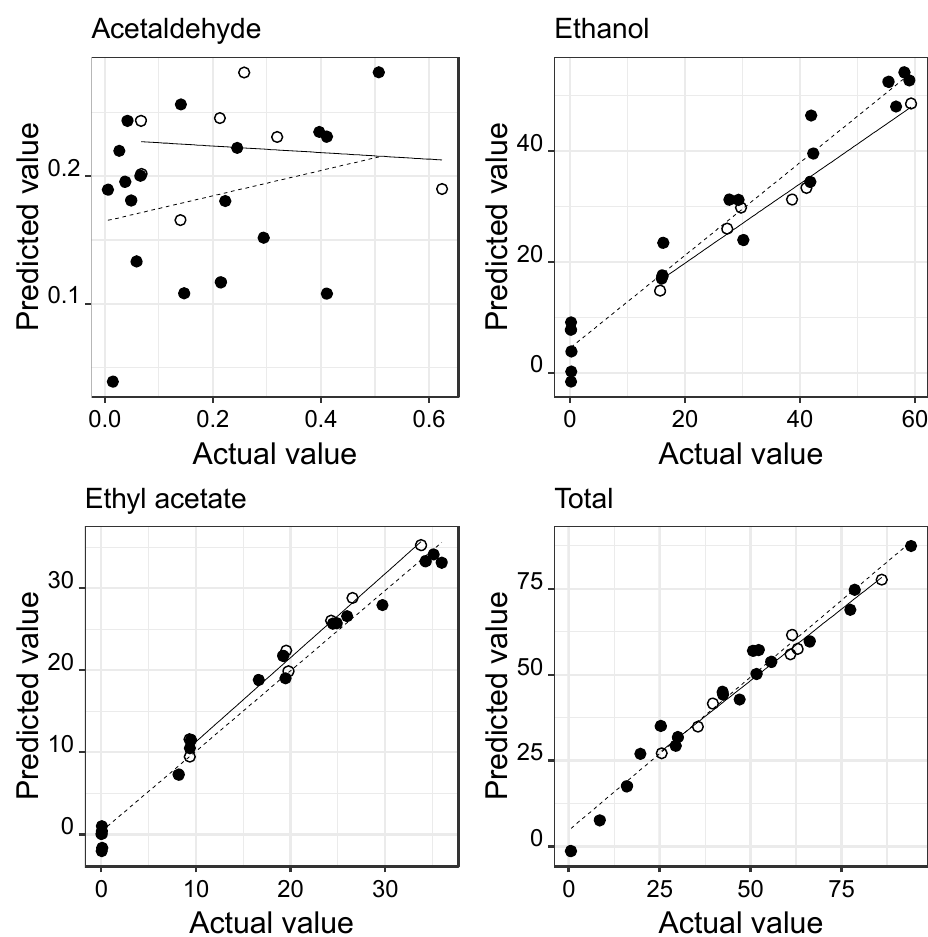
Figure 4. Enose predictive performance in relation to the expected concentrations (g/L) of the compounds in the mixtures of the 3 functional groups and the total mass concentration (g/L) of these organic compounds; filled circles—training data; open circles—testing data.